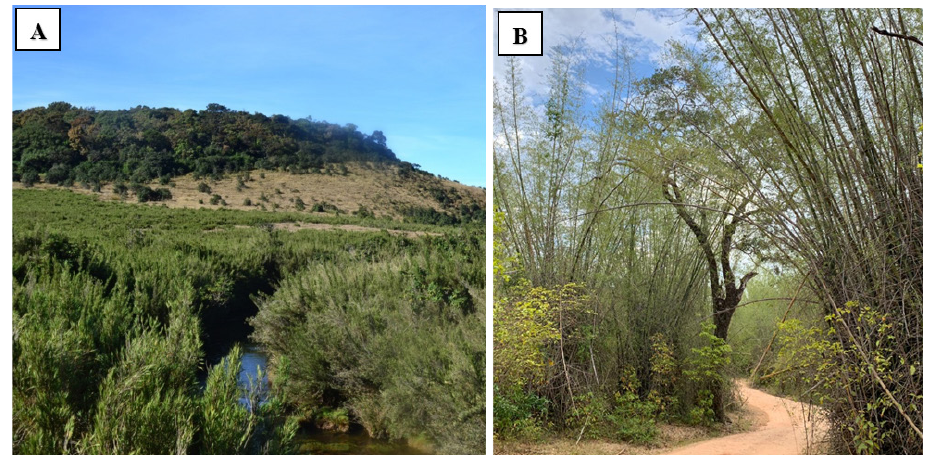
Figure 5: A: Kuruna densifolia (an endemic), B: Bambusa bambos (a native) are expanding their populations in the Horton Plains National Park in the Central Highlands and Minneriya National Park, North Central Province of Sri Lanka, respectively. © Tharanga Wijewickrama and Imesh